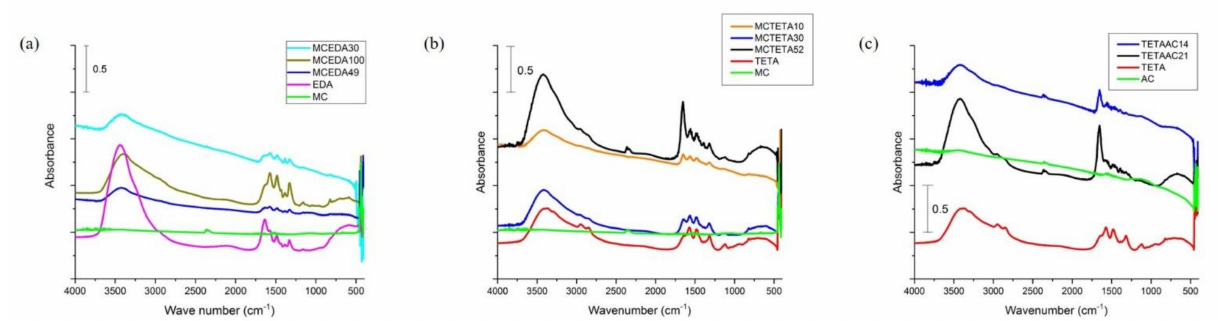
Figure 2. FTIR spectra of ( a ) ethylenediamine (EDA-) and ( b ) triethylenetetramine (TETA)-functionalized mesoporous carbon (MC), and ( c ) TETA-functionalized activated carbon (AC).